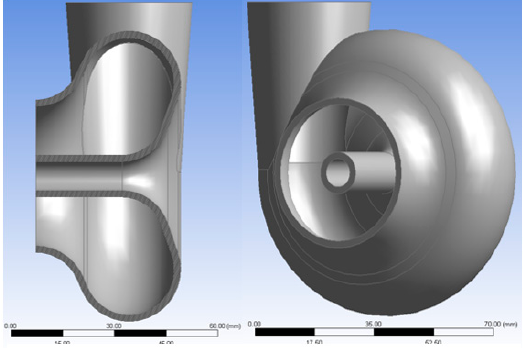
Figure 6. First volute design.